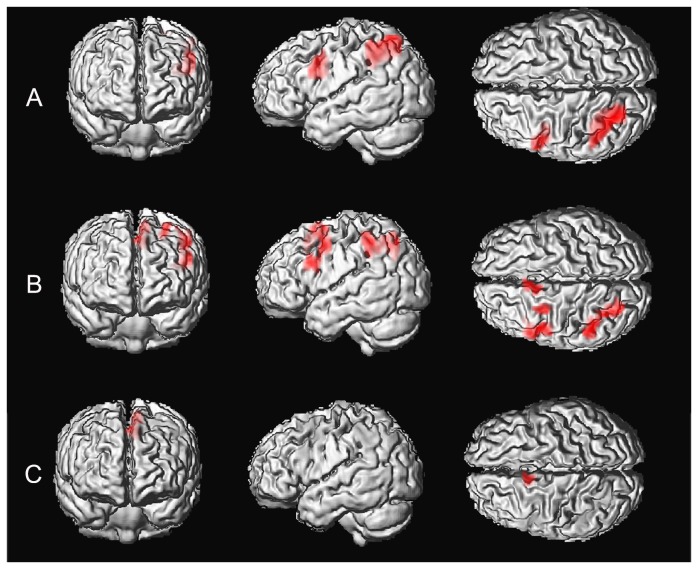
PVSAT baseline task activations for control subjects (A) and SLE patients (B).All of the reported activation clusters survived a FEW-corrected p<0.05 at the voxel level and an extent threshold of 30 voxels. In control subjects, the activations were situated in the left superior and inferior parietal lobes, and the left inferior frontal gyrus. For SLE patients, significantly extended activation was found in the left hemisphere in the superior and inferior parietal lobes, the supplementary motor area, and the middle and inferior frontal gyrus. SLE patients (compared to controls) demonstrated increased activation mainly in the left supplementary motor area (C).